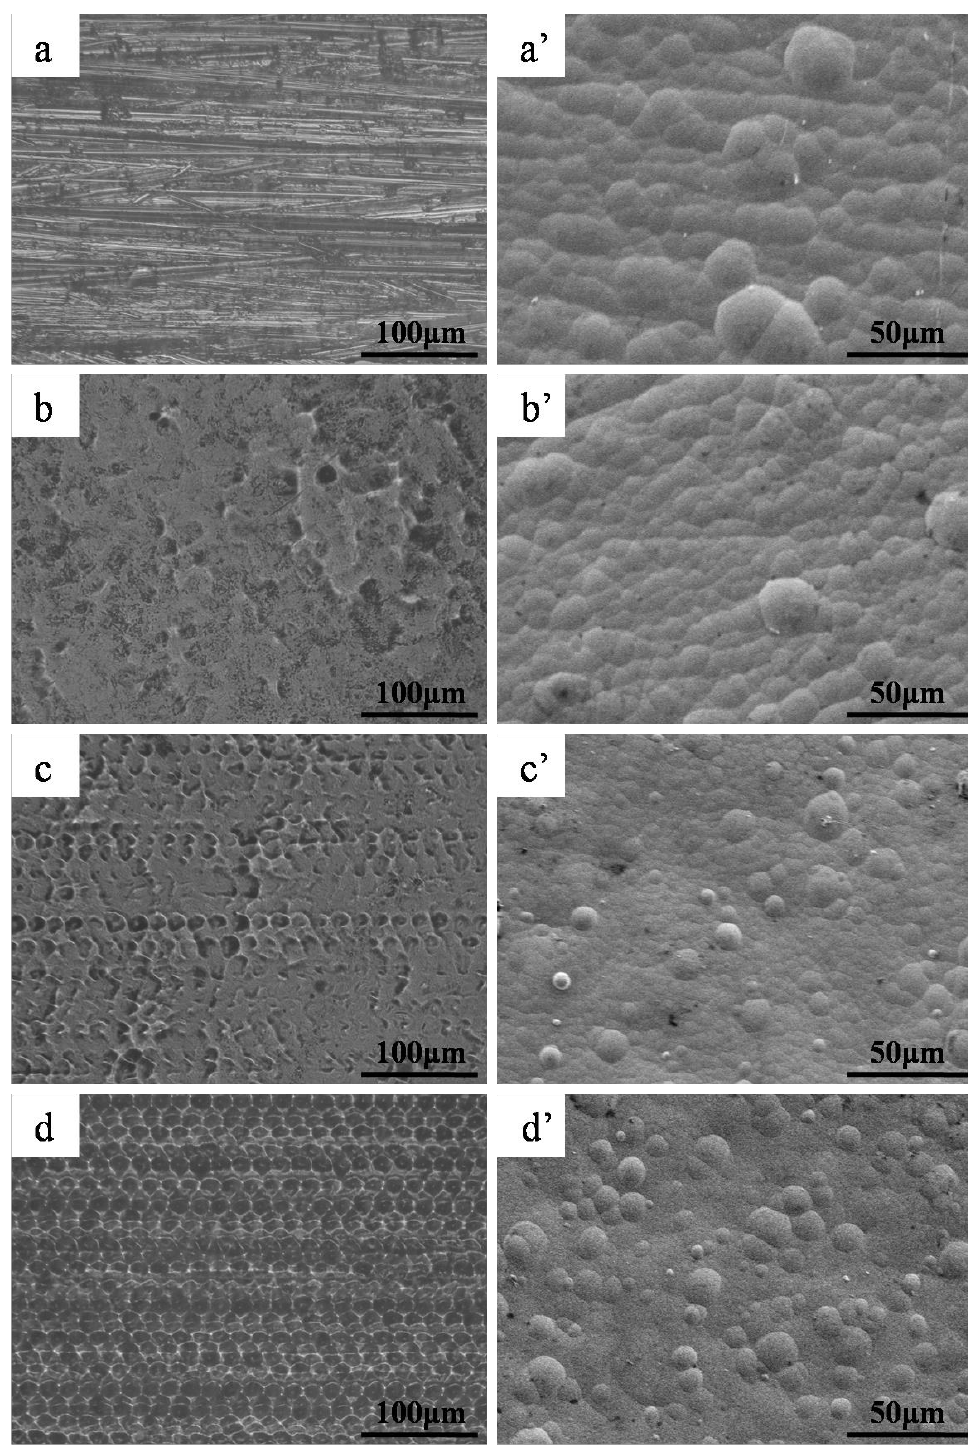
Figure 3. Surface morphologies of the substrates (left) and coatings (right): ( a , a ’) traditional pretreatment; ( b , b ’) 10% laser energy density cleaning; ( c , c ’) 20% laser energy density cleaning; ( d , d ’) 30% laser energy density cleaning.